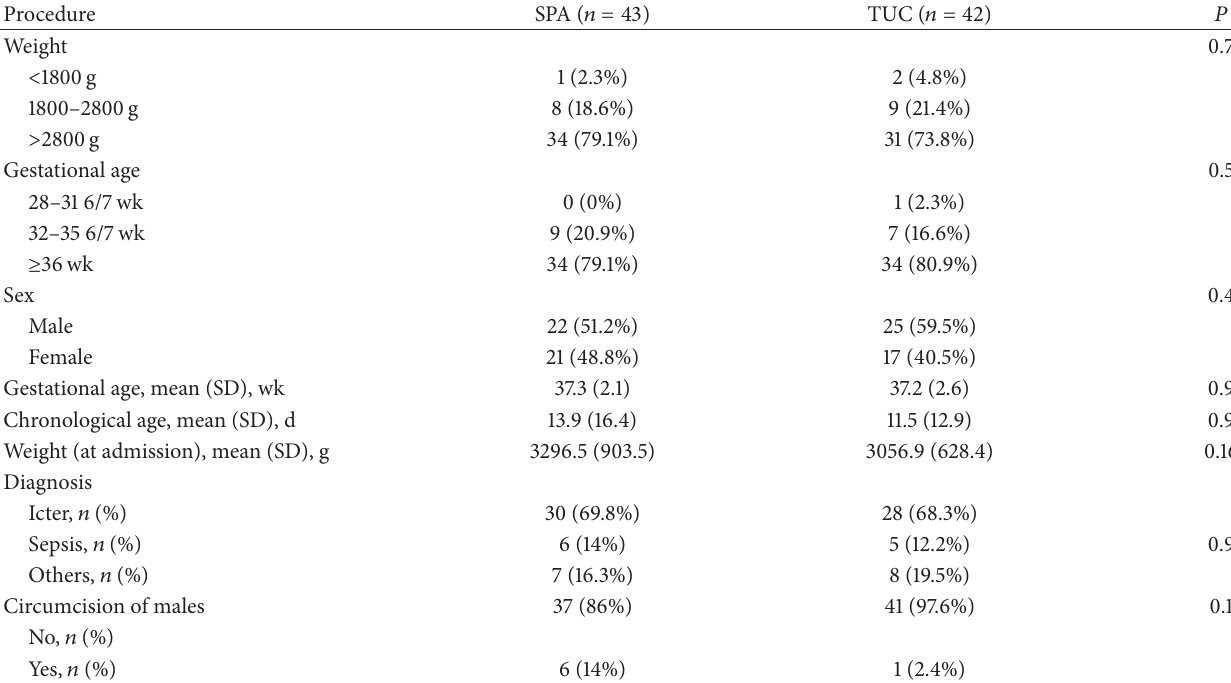
Table 1: Baseline characteristics of the participating